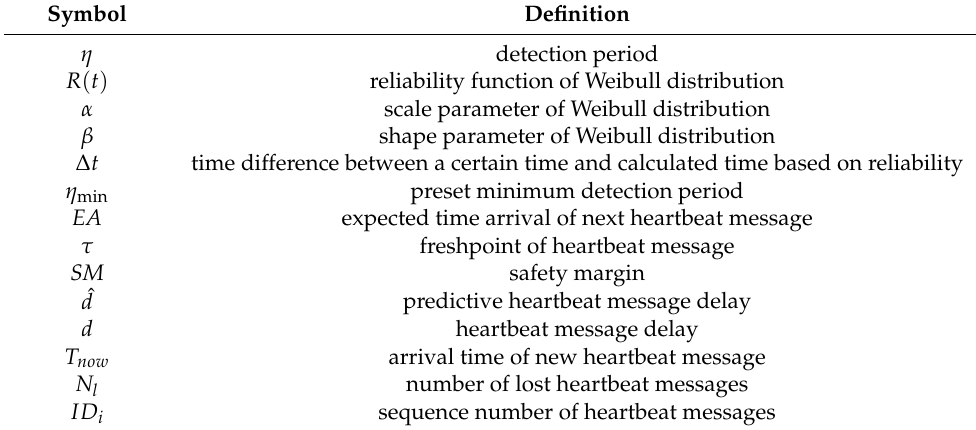
Table 1. Definition of